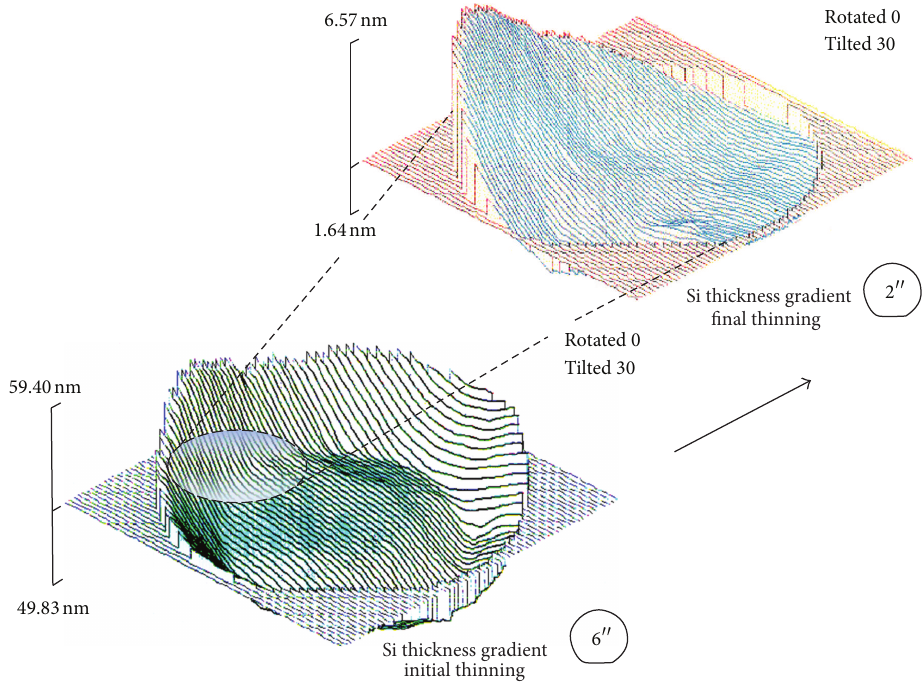
Figure 3: (a) Spectrometer (FT750) map of the initial 6 󸀠󸀠 diameter SIMOX wafer showing the variation of the SOI thickness. (b) Map of 2 󸀠󸀠